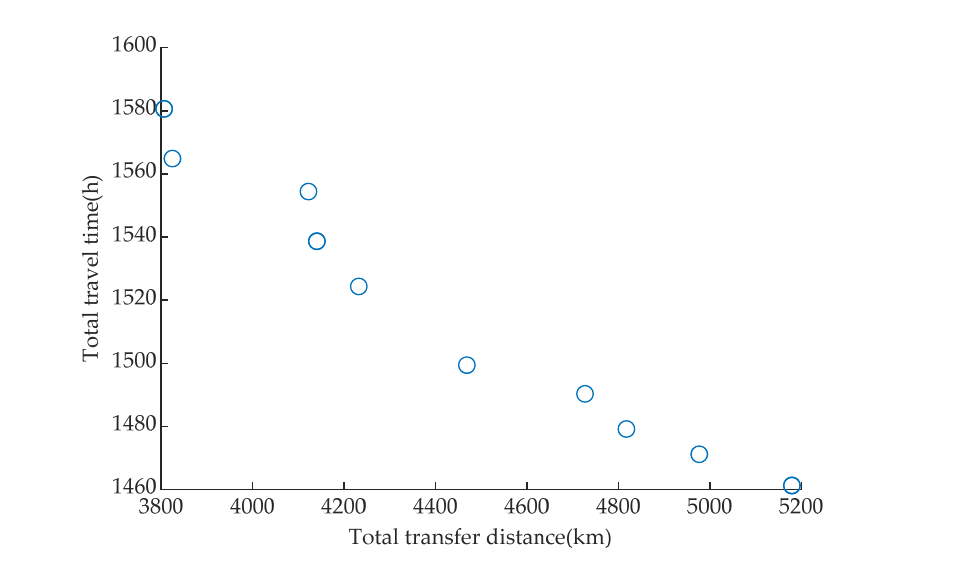
Figure 6. Variation in the relationship between the total transfer distance and total travel time. Table 4. Assignment results for all demand points to selected stations visited by routes. Demand